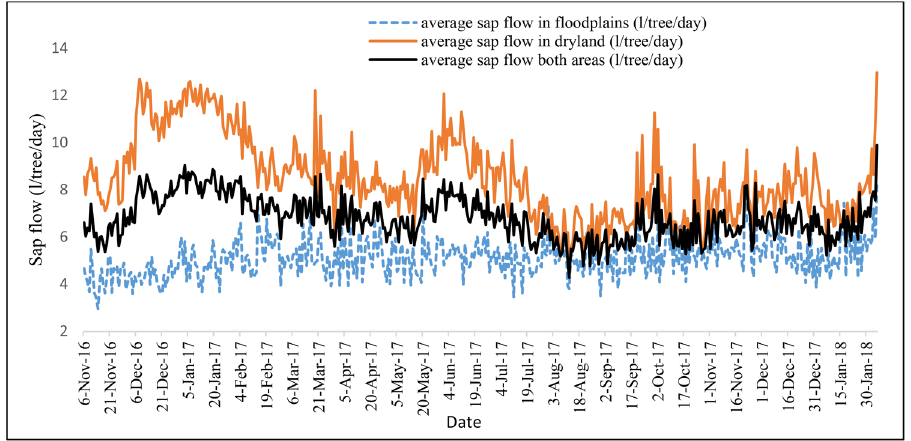
Figure 5. Daily average sap flow of individual Prosopis trees across different habitat types (from 6 Nov 2016 to 30 January 2018).